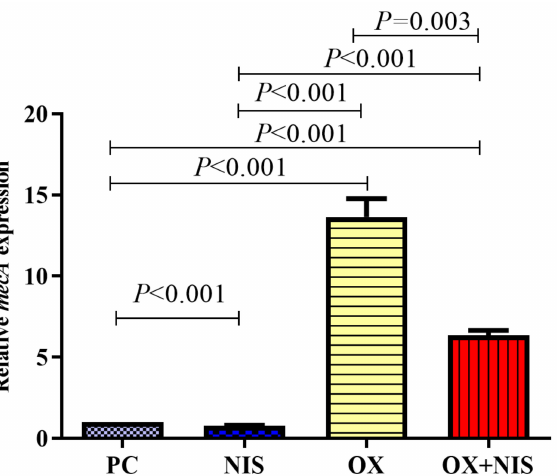
Figure 5. The mecA transcription in MRSA Yn2020070 treat with OX, NIS, and OX + NIS. 2.3. Efficacy of OX + NIS in the Treatment of MRSA-Induced Wound Infections in Mice